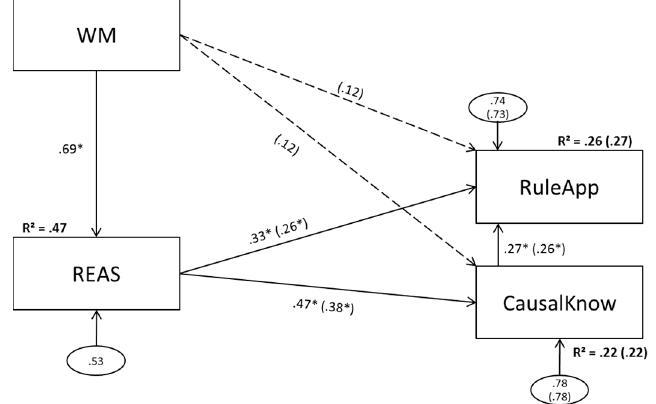
Figure 2. Model 1a(b): Aggregated working memory components as predictors of reasoning; reasoning (and working memory) as predictors of problem solving. WM = working memory; REAS = reasoning; CausalKnow: = causal knowledge; RuleApp = rule application. Dashed lines and values in parentheses depict changes in model 1b. Statistically significant paths are marked with an asterisk ( α =